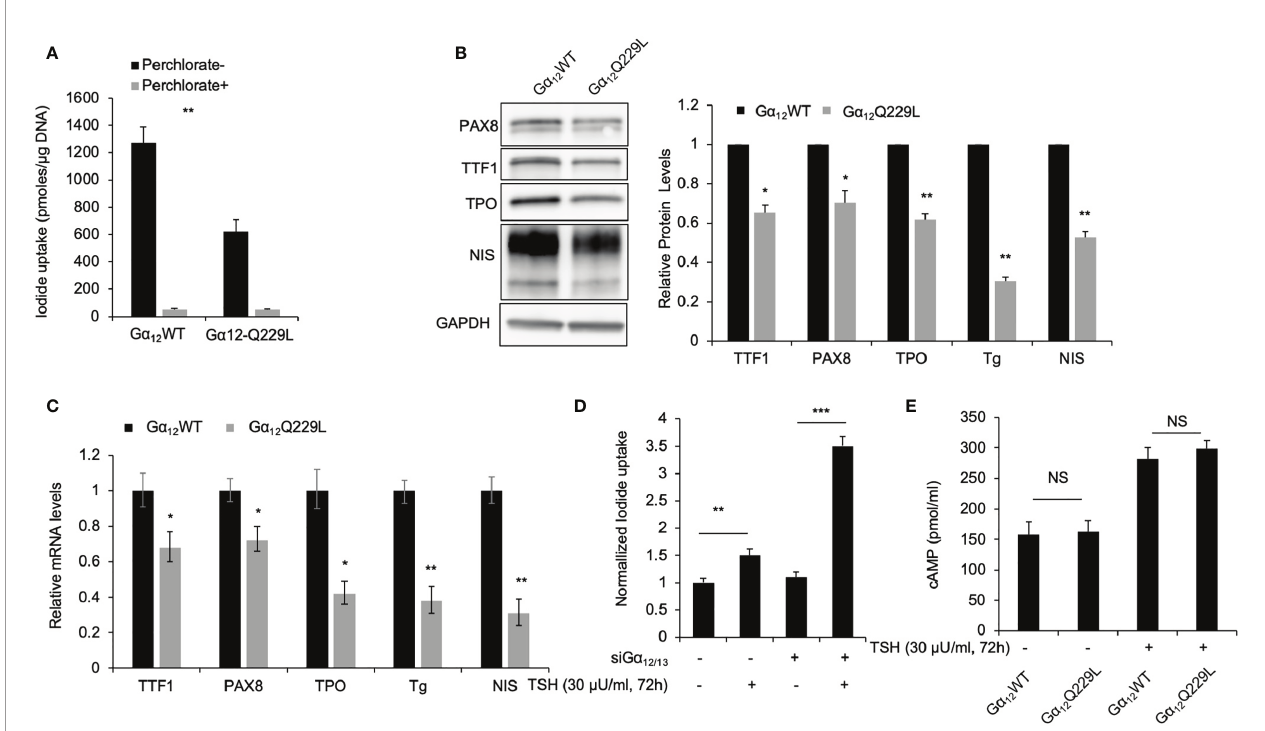
FIGURE 4 | Constitutively active G a 12/13 is associated with thyroid speci fi c maker loss and decreased iodide uptake. (A) Radioiodide uptake of PCCL3 cells stably transfected with G a 12 Q229L or G a 12 WT. Data represent means ± SEM of 3 independent experiments. (B) Immunoblots of TTF1, PAX8, TPO and NIS in PCCL3 cells stably transfected with G a 12 Q229L or G a 12 WT. GAPDH is used as a loading control for normalization. Bar charts, Relative TTF1, PAX8, TPO, Tg and NIS protein levels in PCCL3 cells stably transfected with G a 12 Q229L or G a 12 WT. Tg levels were detect by RIA. Data represent means ± SEM of 3 independent experiments. (C) Bar charts, Relative mRNA levels of TTF1, PAX8, TPO, Tg and NIS in PCCL3 cells stably transfected with G a 12 Q229L or G a 12 WT. Data represent means ± SEM of 3 independent experiments. (D) Normalized radioiodide uptake of PCCL3 cells transiently transfected with siG a 12/13 or siNT then treated with 30 m U/ml TSH or control. Data represent means ± SEM of 3 independent experiments. (E) Bar chart, cAMP levels in PCCL3 cells stably transfected with G a 12 Q229L or G a 12 WT incubated with 30 m U/ml TSH. Data are representative of 3 sets of independent experiments. * P < 0.05, ** P < 0.01, *** P < 0.001, NS, not signi fi cant.